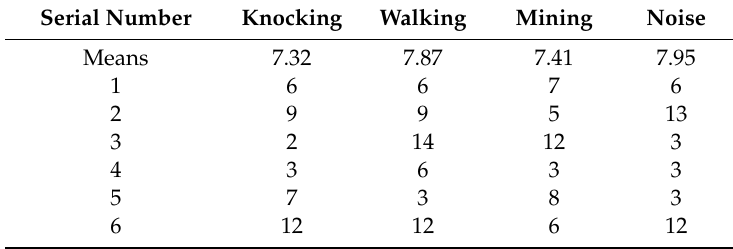
Table 1. AMNBP values of the four types of events without adaptive adjustment.